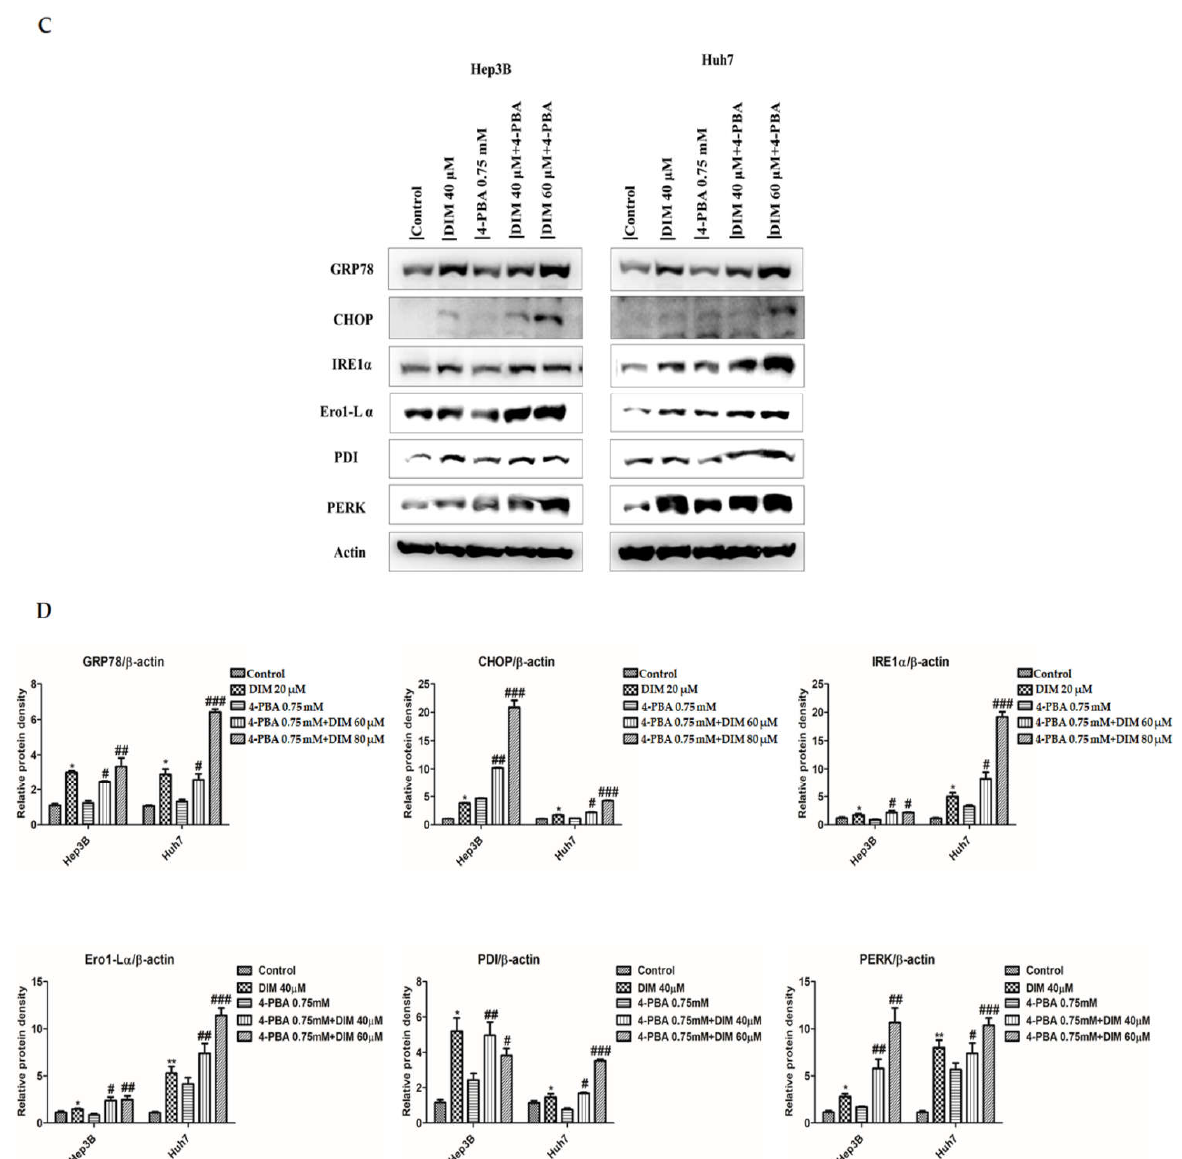
Figure 5. DIM regulates ER stress in HCC cell lines. ( A ) Evaluation of changes of ER stress-related markers at protein level after DIM treatment for 24 h in Hep3B and Huh7 cells by Western blot analysis. ( B ) Bar graphs represents the relative protein expression normalized to β-actin. ( C ) Effect of ER stress inhibitor 4-PBA on DIM-induced ER stress in Hep3B and Huh7 cells based on Western blot analysis. ( D ) Quantification of relative protein expression normalized to β-actin. Provided data represents the mean ± SE of three independent experiments. *, p < 0.05; **, p < 0.01; and ***, p < 0.001 denote significant variation compared to the control group and # , p < 0.05; ## , p < 0.01; and ### , p < 0.001 denote significant variation compared to the 4-PBA treated group.